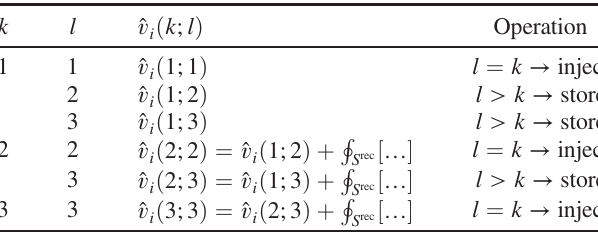
TABLE I. Example of the extrapolation using Eq. (4) with N ¼ 3 . Modified after Broggini et al. [24]. The subscript t ð x emt ; k ; l Þ on x emt were omitted for the dependency of ˆ v full ;i improved